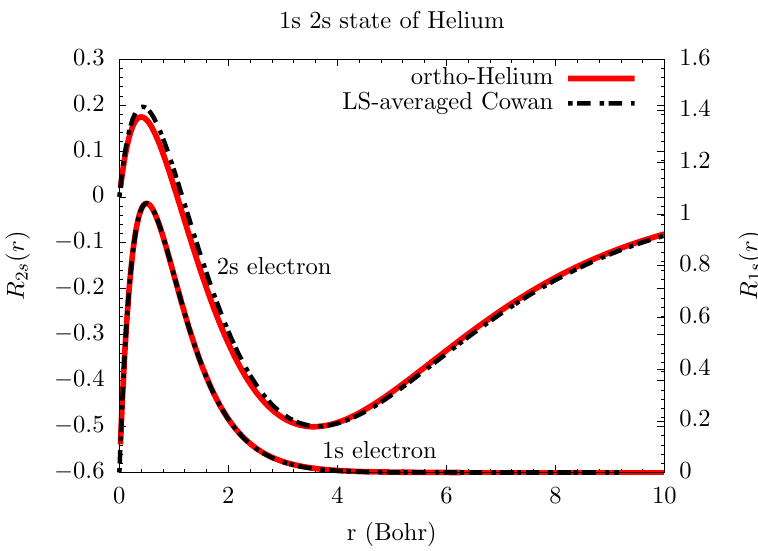
Figure 2. The ortho-helium wavefunctions compared with Cowan’s 1s 2s wavefunction. The new calculations with exact exchange are given in red, while Cowan’ calculation are in dot-dashed black